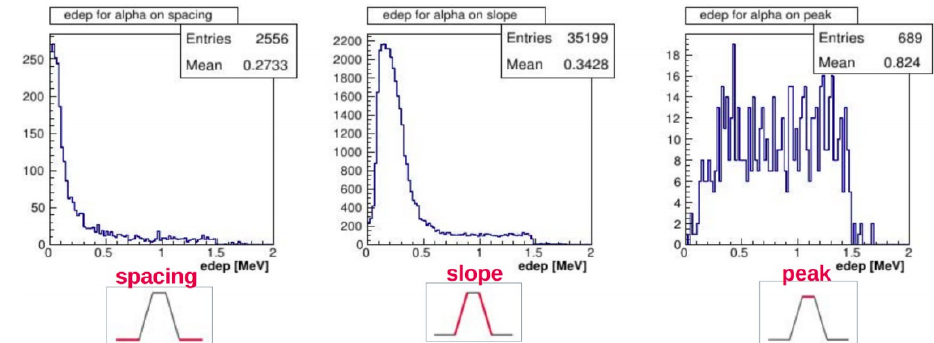
Fig. 3. Deposited energy distribution of α particles produced by 1M thermal neutrons on the grooved cathode for three different regions: spacing, slope and peak. Similar distribution can be found for 7 Li particles too.